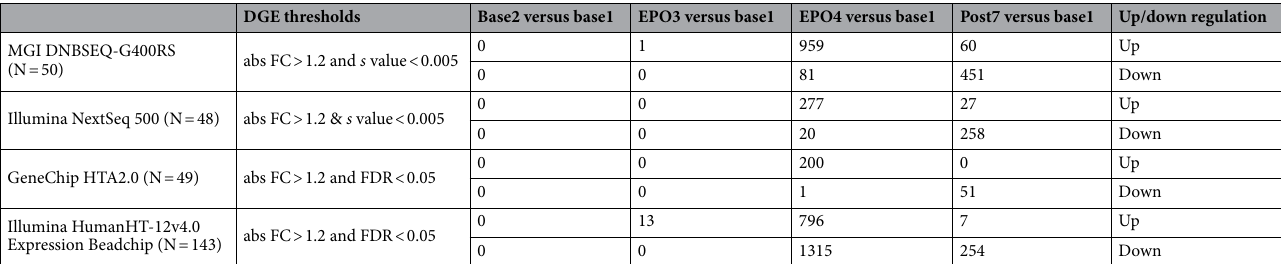
DGE thresholds Base2 versus base1 EPO3 versus base1 EPO4 versus base1 Post7 versus base1 Up/down